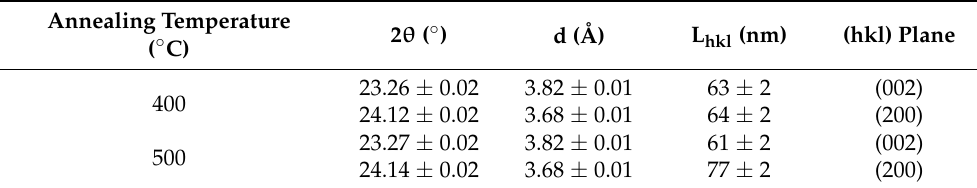
Table 2. Diffraction angle (2 θ ), interplanar spacing (d), and crystallite size (L hkl ) values of WO 3 films annealed at 400 ◦ C and 500 ◦ C.